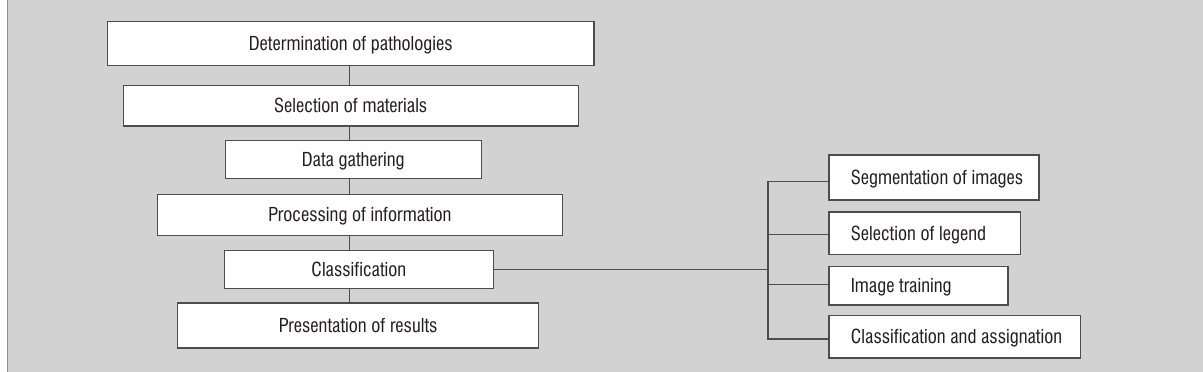
Phases for the identification of stone